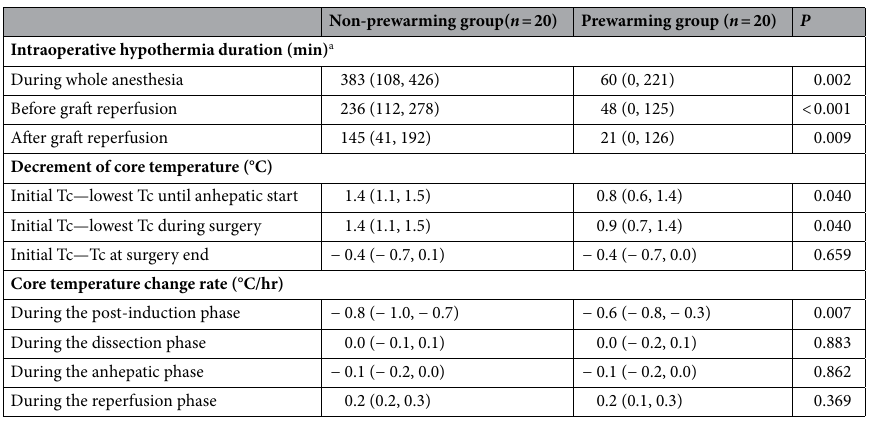
Table 2. Hypothermia duration and core temperature change during the indicated periods. Data are presented as frequency (percent) or median (25th percentile, 75th percentile). Tc, core temperature. a 10 min after graft reperfusion was not counted.